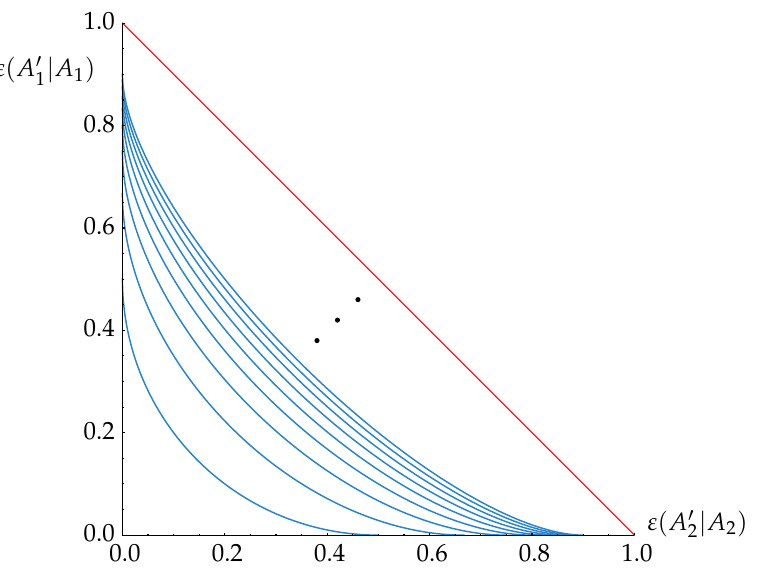
Figure 7. The uncertainty tradeoff curves for discrete position/momentum pairs, with a discrete metric. In this case, all uncertainty regions, also the one for preparation uncertainty,